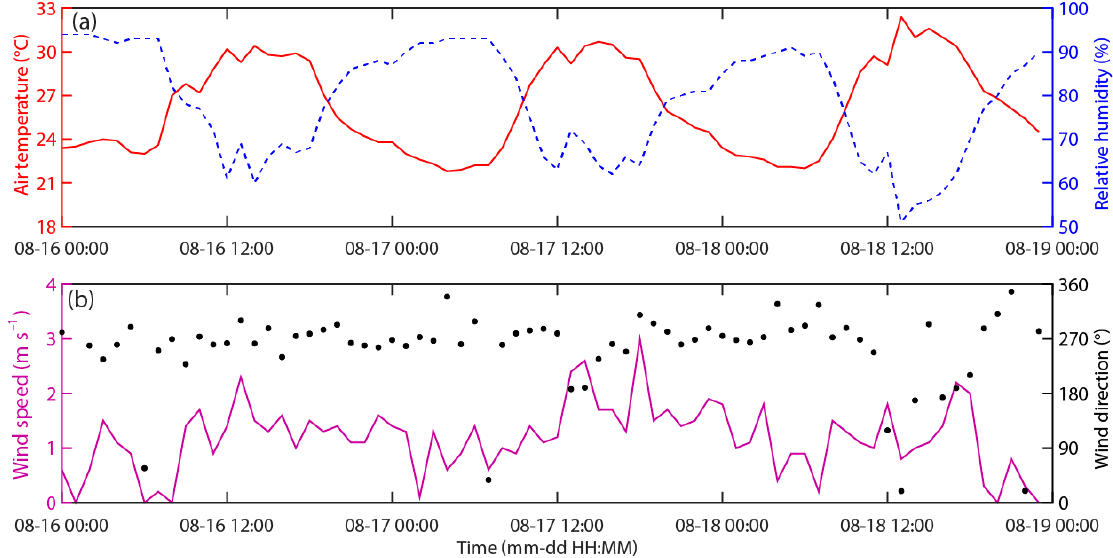
Figure 2. Time series of hourly ( a ) 2-m air temperature, relative humidity, ( b ) 10-m wind speed, and wind direction observed at the ground AWS during the observation period from 00:00 LT (local time) on August 16 to 23:00 LT on August 18, 2017.